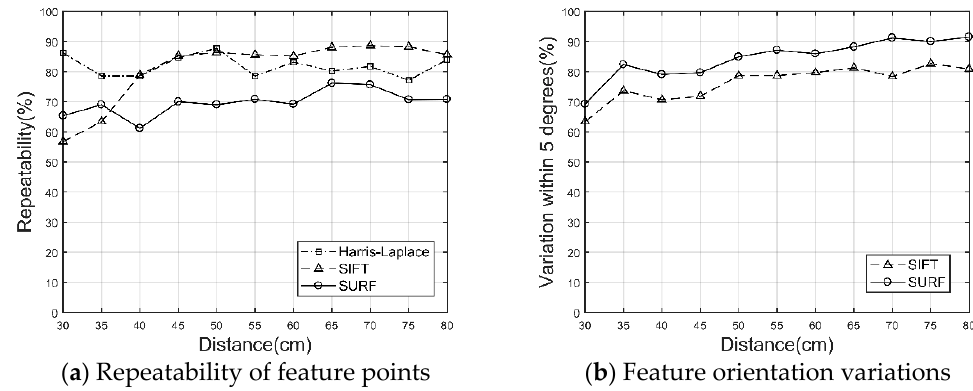
Figure 3. The variations of feature points in screen-cam process.